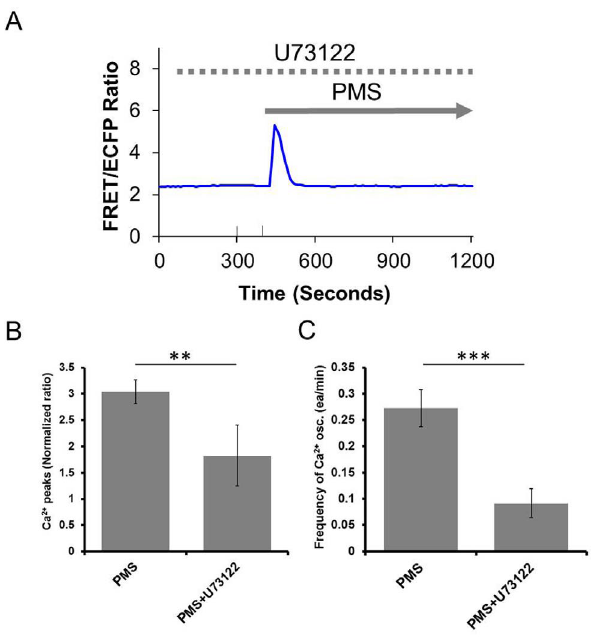
Figure 4. The effect of PLC inhibitor on the PMS-induced calcium oscillations. (A) In U73122 (5 m M, 30 min) pretreated hMSCs, PMS does not induce sustainable calcium oscillations. (B–C) Both amplitude and frequency of PMS-calcium oscillations are inhibited in the presence of U73122 (PMS, n=4; PMS + U73122, n=4, **P , 0.01 and ***P , 0.001).